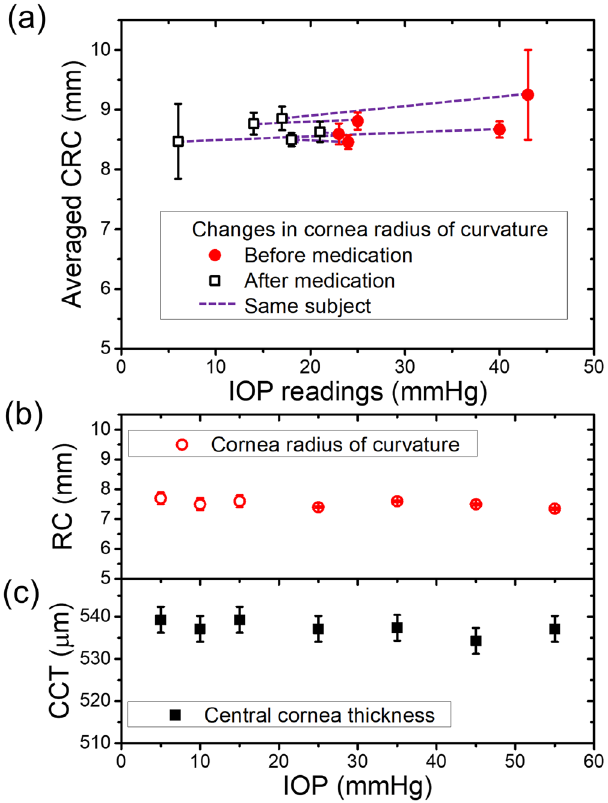
Figure 4. The deformation of human subjects governed by intraocular pressure changes. The averaged corneal radius curvature of human eye before (closed red circle) and after (open black square) medications is displayed in ( a ). The data pair connected by dashed line is measured from the subject of the same patient. The IOP were measured by NCT 4 h after medications. The dependence of the cornea radius of curvature and the central corneal thickness on IOP observed from the cannulated human subject are shown in ( b ) and ( c ), respectively. The measurement for each IOP change is completed within 1